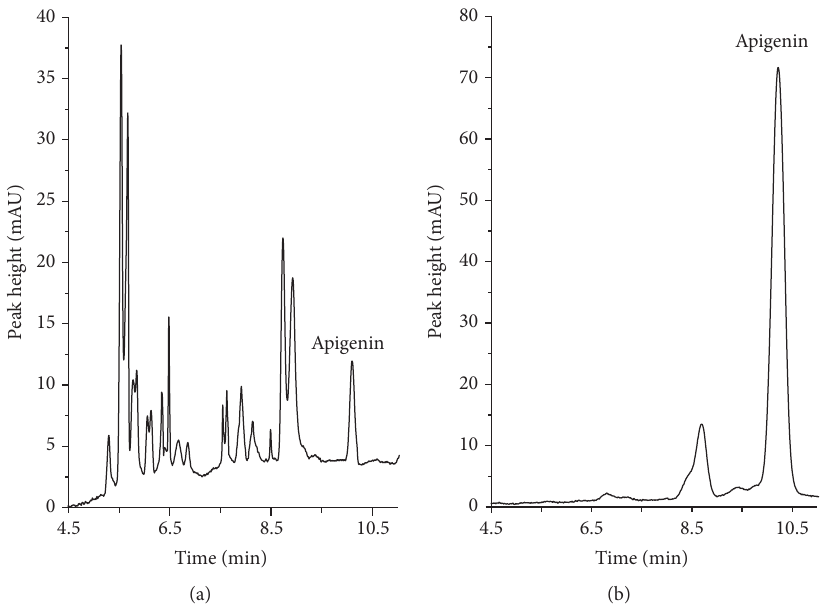
Figure 4: Representative chromatograms of oregano (a) and parsley leaves (b), assayed according to the procedure described in Section 2.4. Electrophoretical conditions are described in Section